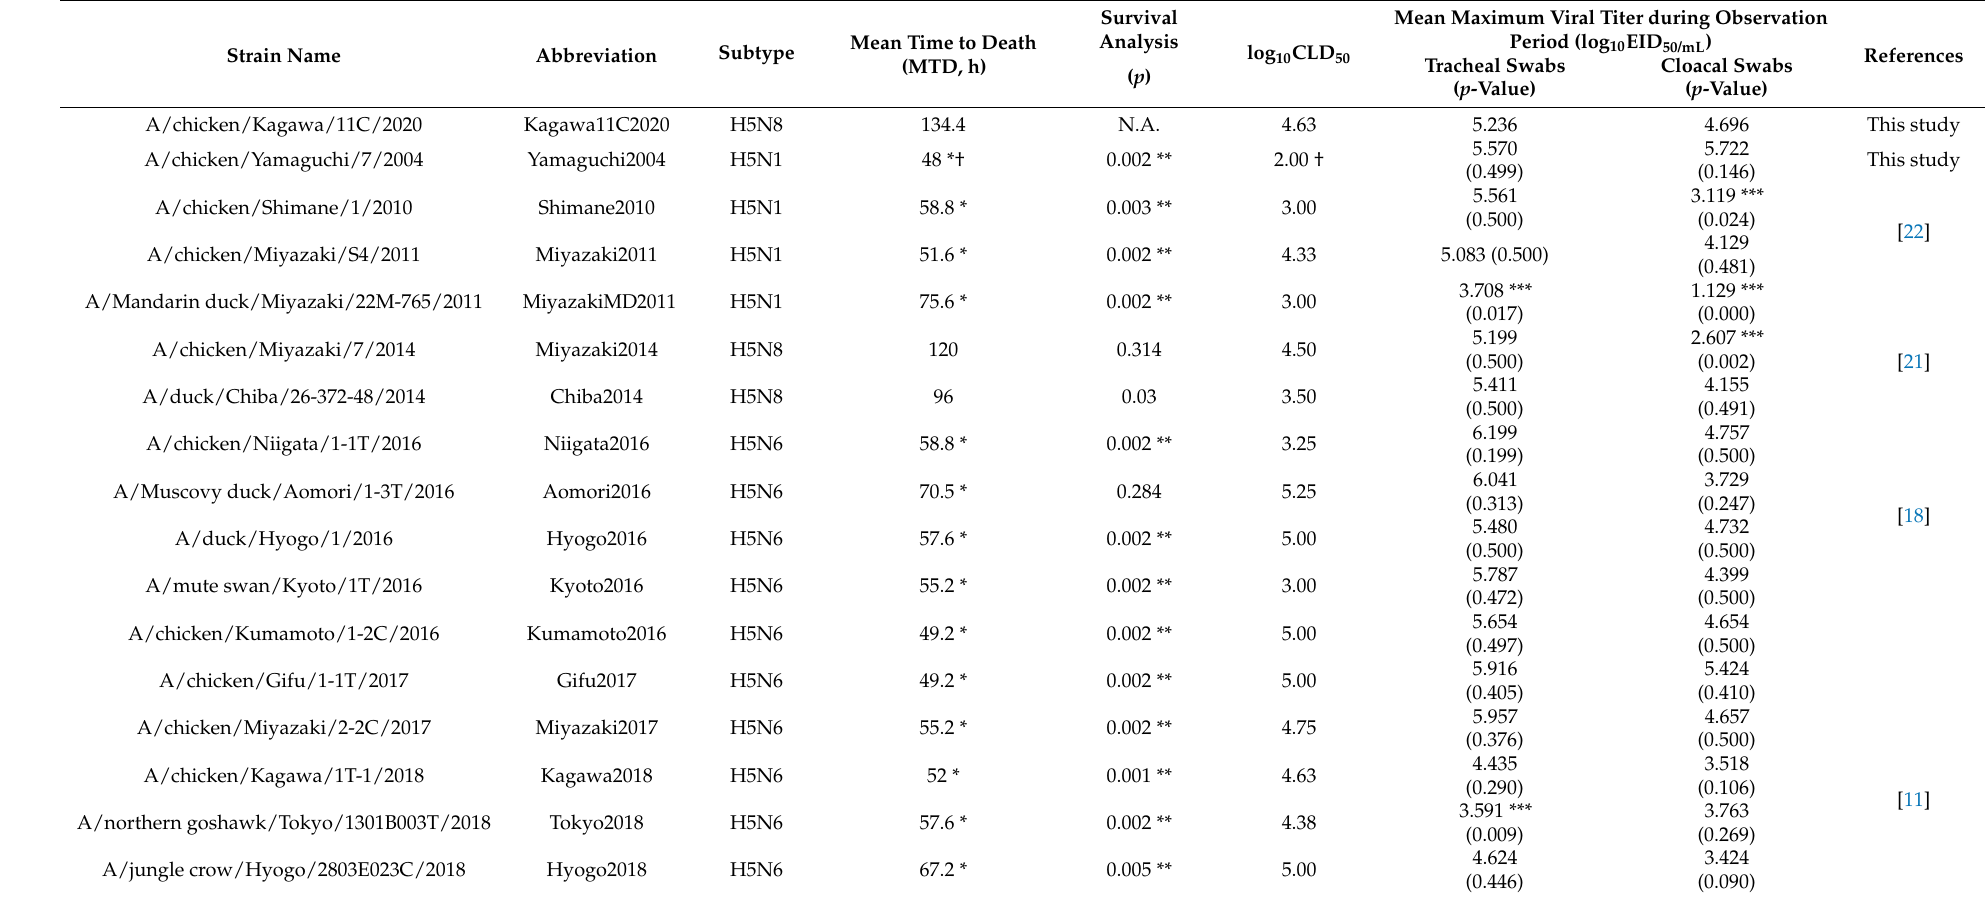
Table 1. Mean time to death, 50% chicken lethal dose (CLD 50 ), results of survival analysis, and mean maximum viral titers in tracheal and cloacal swabs during the observation period